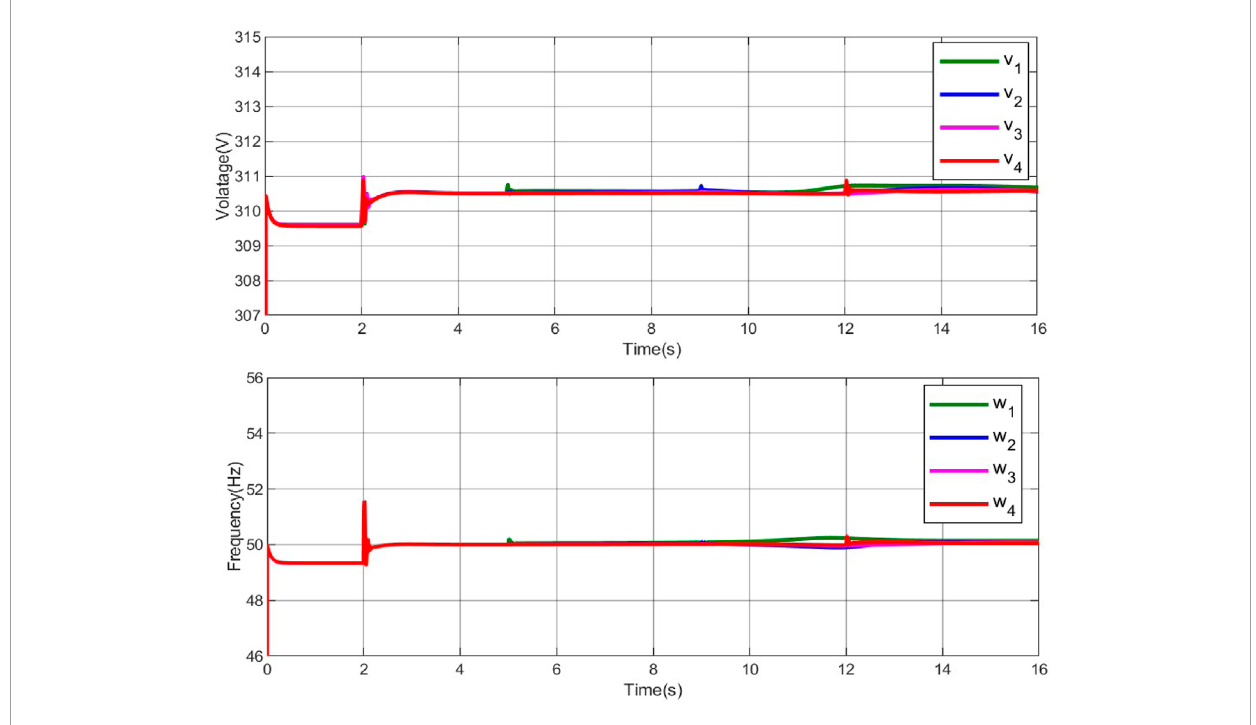
FIGURE 3 Trajectories of voltage and frequency with the secondary fault-tolerant controller (31) and (38) under